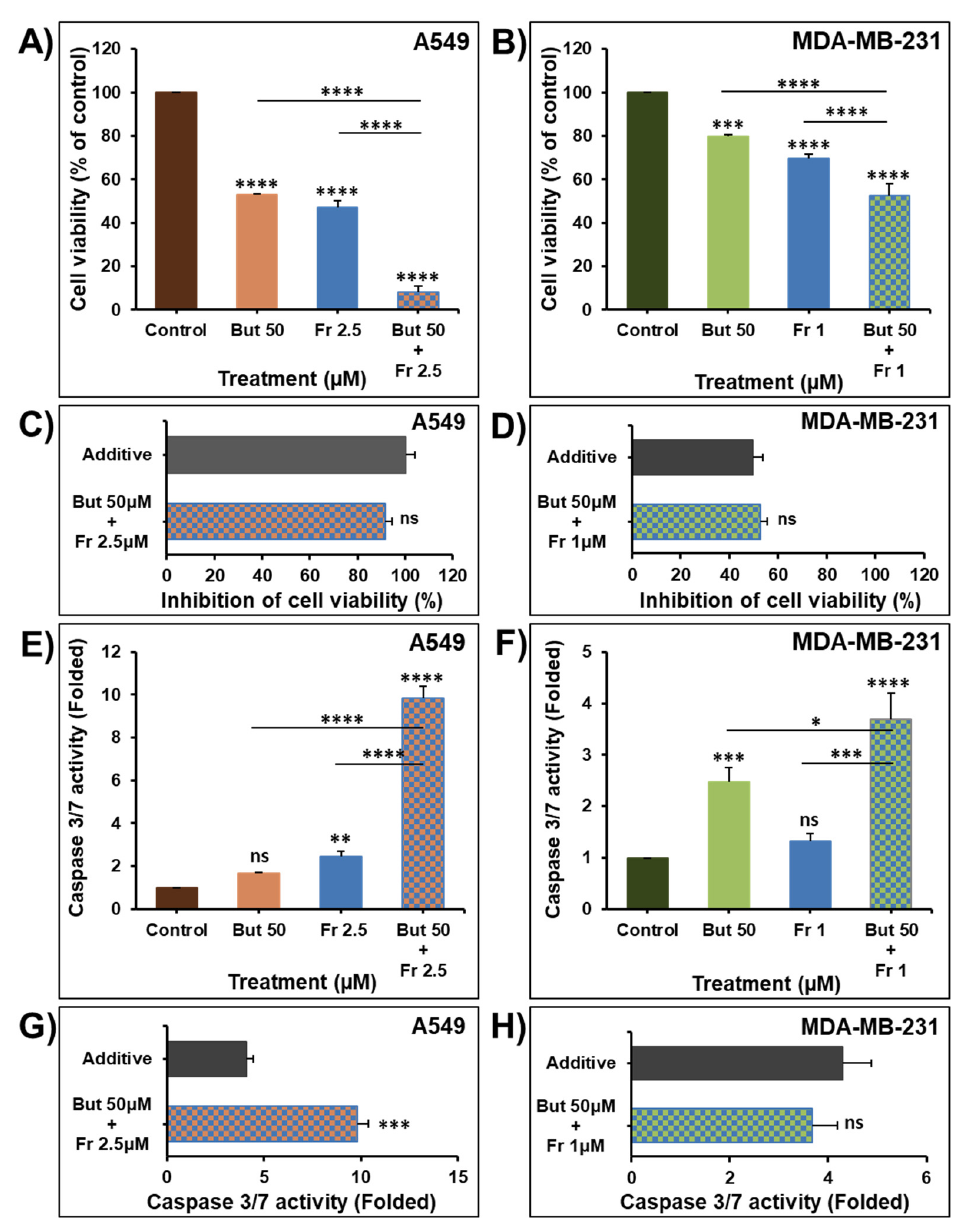
Figure 6. Effect of butein in combination with frondoside-A on the inhibition of cell viability of A549 ( A ) and MDA-MB-231 cells ( B ) after 48 h treatment. Effect of combinations of butein and frondoside-A on cell viability compared with the calculated additive effects of the two drugs alone ( C , D ). Induction of caspase 3/7 activity was also analyzed in A549 and MDA-MB-231 cells treated for 48 h with frondoside-A (2.5 and 1 µM, respectively), butein (50 µM) and their combination ( E , F ). Effect of combinations of butein and frondoside-A on caspase 3/7 activity compared with the calculated additive effects of the two drugs alone ( G , H ). Data were normalized to the number of viable cells per well and expressed as fold induction compared to the control group. All experiments were repeated at least three times. Columns are means; bars are S.E.M. The statistical significance is compared to the control except for the specified lines. * Significantly different at p < 0.05, ** Significantly different at p < 0.01, *** Significantly different at p < 0.001, **** Significantly different at p < 0.0001. ns—non-significant.